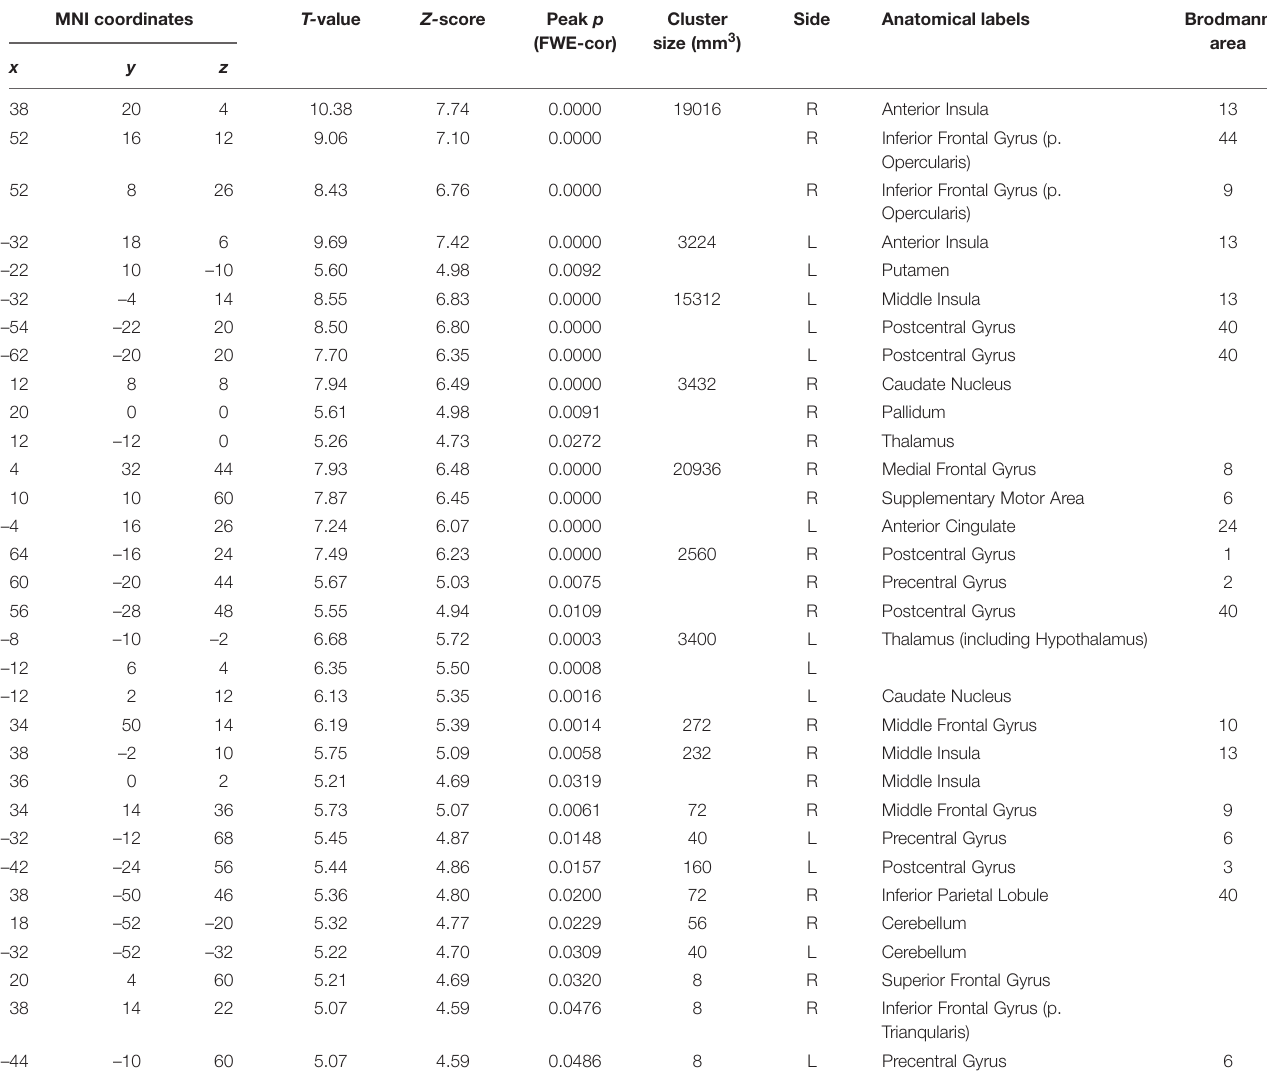
TABLE 3 | The peak coordinates displayed significant responses by the comparison